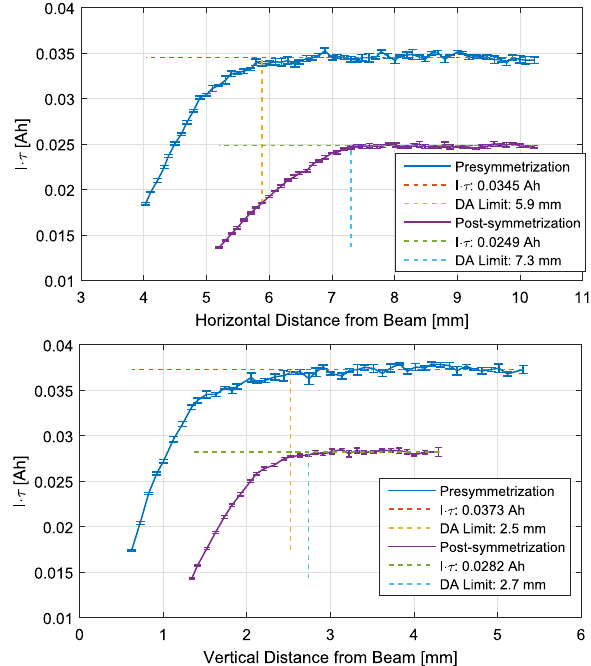
FIG. 15. I · τ versus horizontal (top) and vertical (bottom) scraper distance from beam center. “ Presymmetrization ” refers to sextupole settings based solely on rotating coil calibration curves, while “ post-symmetrization ” refers to the sextupole settings found in Sec. V B. The post-symmetrization settings resulted in an increase in the horizontal dynamic aperture. The measure- ments were done at a beam current of 3 mA, and a short bunch train. The difference in lifetime was due to the lower vertical emittance from a lower coupling in the post-symmetrization lattice.